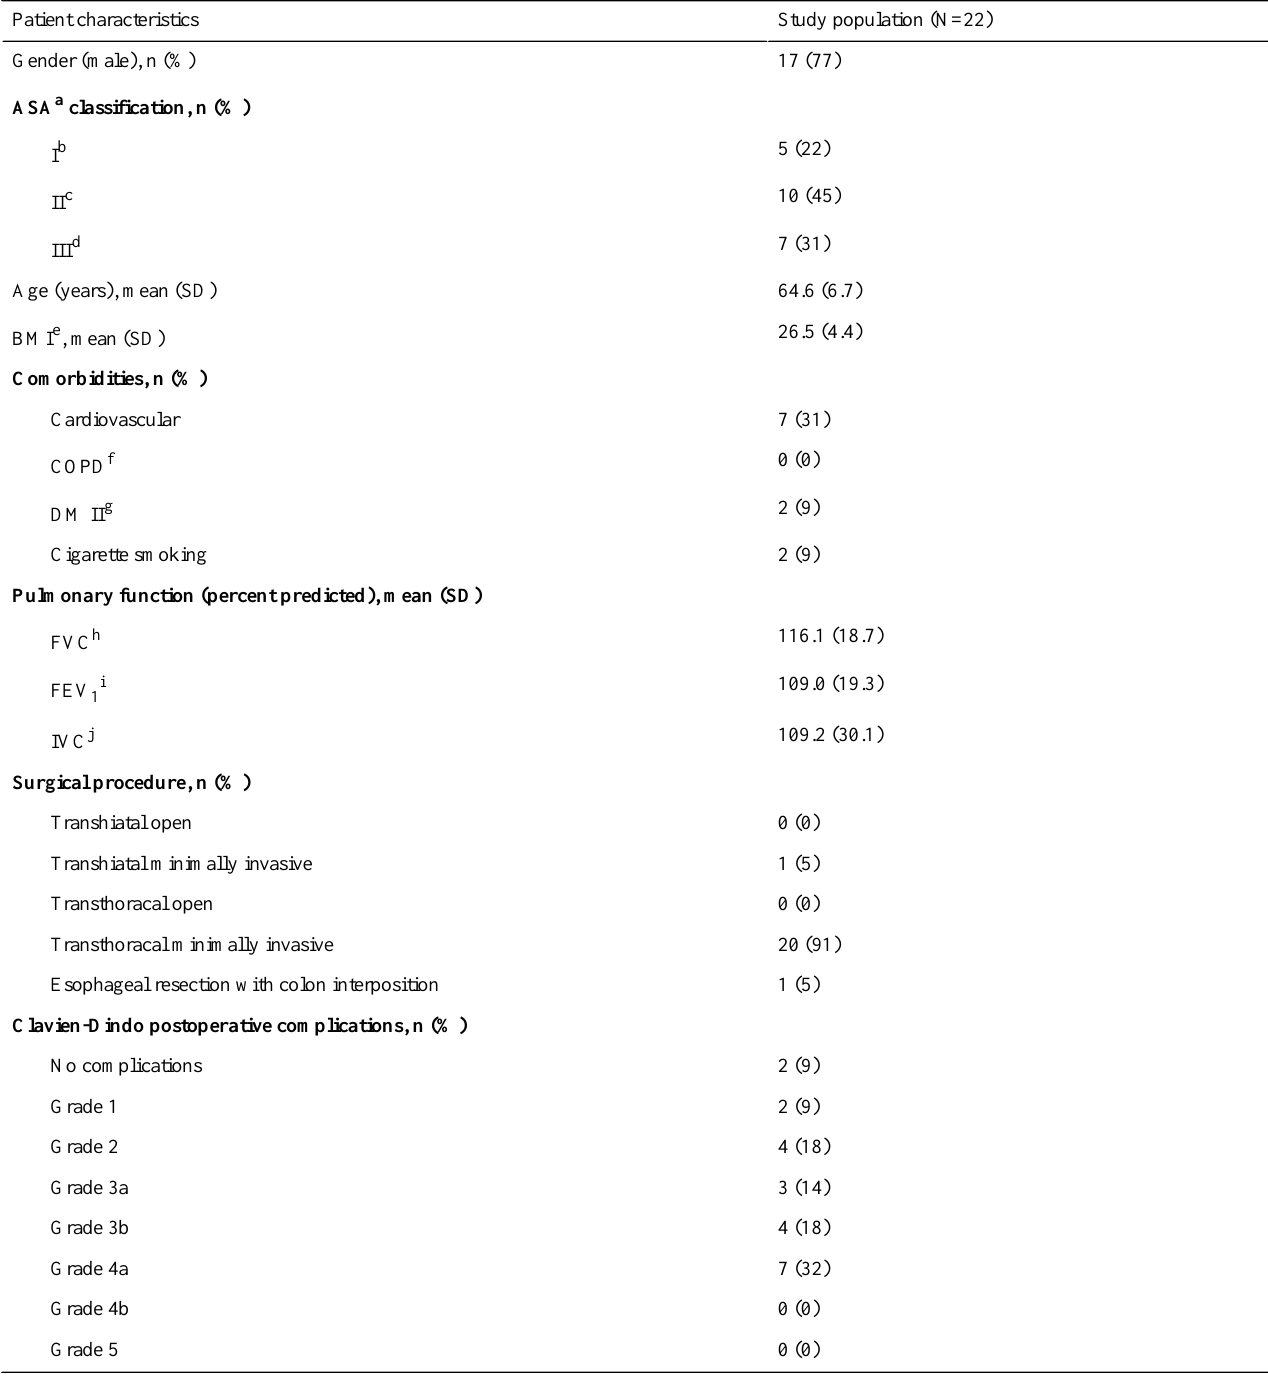
Table 1. Characteristics of the entire study